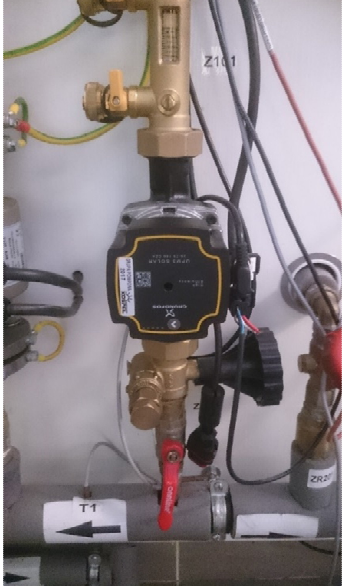
Figure 9. Grunndffos circulating pump.